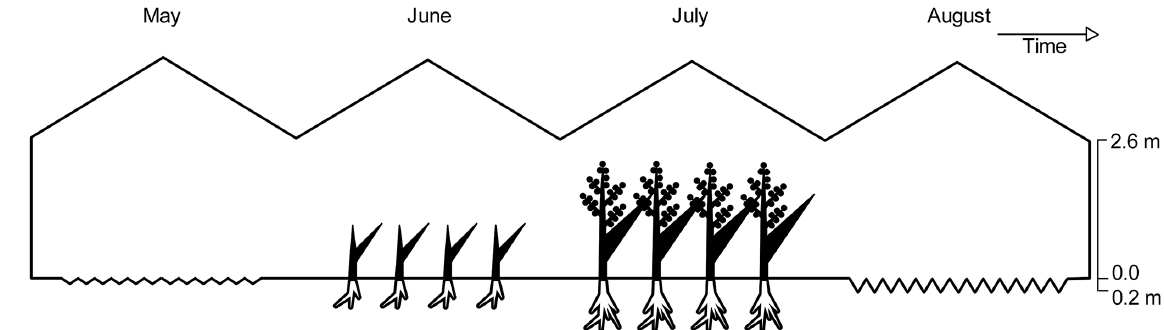
Figure 4. Sorghum rotation, from seeded in May to incorporation in the soil in August using a tiller.